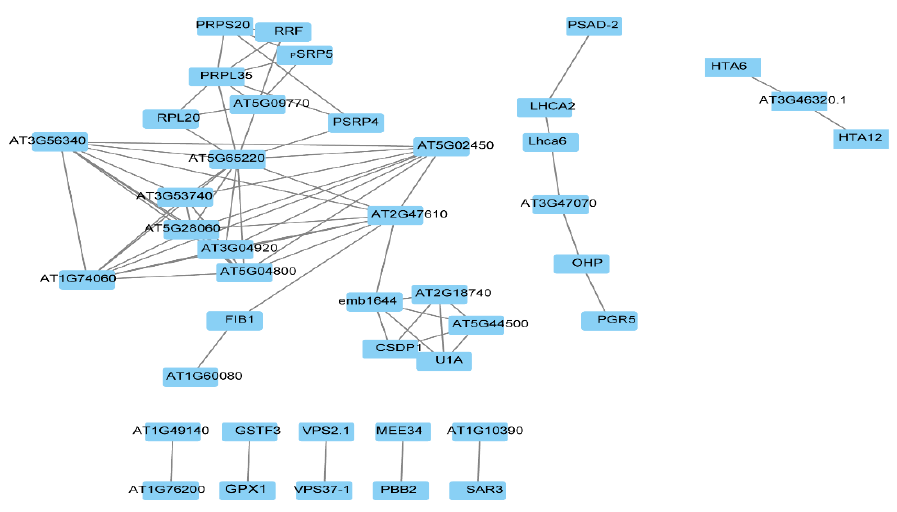
Figure 6. Protein interaction network (PPI) analysis of STO-dependent UV-B-induced proteins.